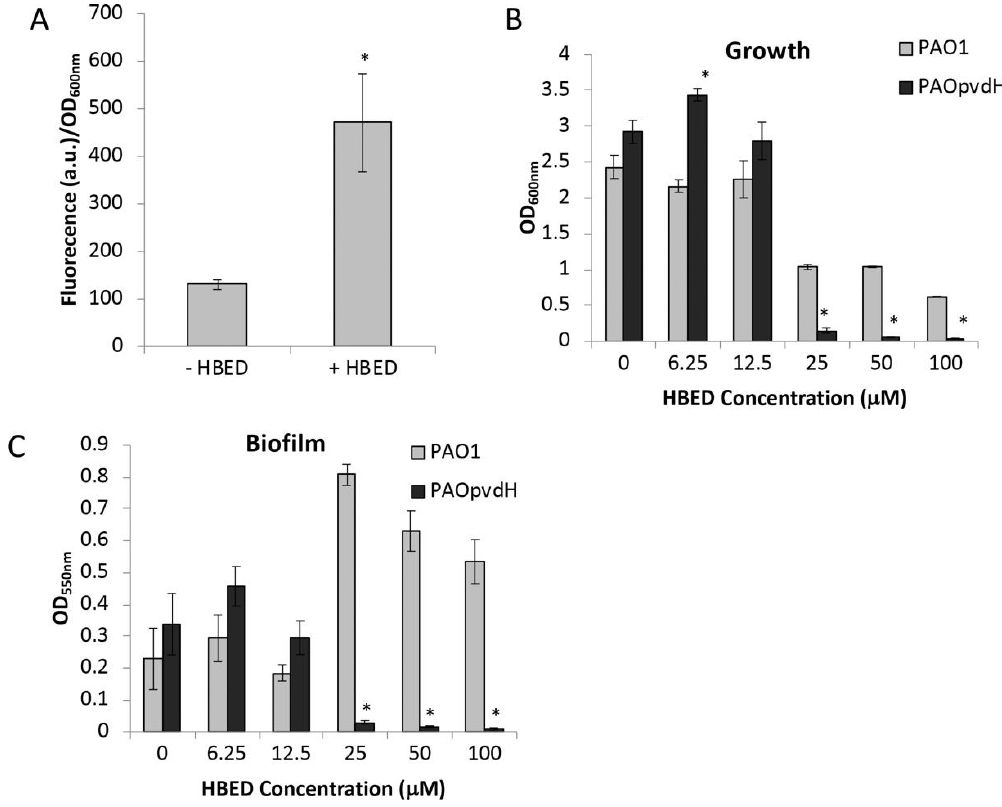
Figure 3. Effect of N,N’ -bis (2-hydroxybenzyl) ethylenediamine- N,N’ -diacetic acid (HBED) on Figure 3. E ff ect of N,N’-bis (2-hydroxybenzyl) ethylenediamine-N,N’-diacetic acid (HBED) on pyoverdine production in PAO1. (A) Pyoverdine production from PAO1 grown in succinate medium pyoverdine production in PAO1. ( A ) Pyoverdine production from PAO1 grown in succinate medium with 10  M FeCl 3 in the presence and absence of 25 µM HBED. The values represent the mean levels with 10 µ M FeCl 3 in the presence and absence of 25 µ M HBED. The values represent the mean levels of of fluorescence (405nm/460 nm) adjusted for growth (OD 600nm ) +/- standard error of the mean (SEM) fluorescence (405 nm / 460 nm) adjusted for growth (OD 600 nm ) +/ − standard error of the mean (SEM) of of three biological replicates. (B) Growth and (C) biofilm formation of PAO1 and the pyoverdine three biological replicates. ( B ) Growth and ( C ) biofilm formation of PAO1 and the pyoverdine deficient deficient mutant PAO pvdH in succinate medium with 10  M FeCl 3 with HBED at concentrations mutant PAO pvdH in succinate medium with 10 µ M FeCl 3 with HBED at concentrations indicated. indicated. * denotes significantly different values compared to PAO1 with the equivalent * denotes significantly di ff erent values compared to PAO1 with the equivalent concentration of HBED concentration of HBED determined using Student’s t-test (P<0.05). determined using Student’s t -test ( P <